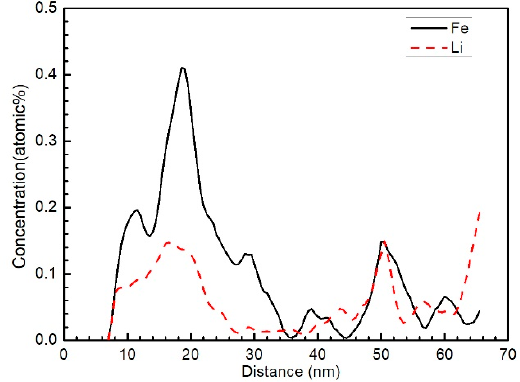
Figure 5. The concentration curves of Fe and Li in the analysis cylinder (as shown in Figure 4).